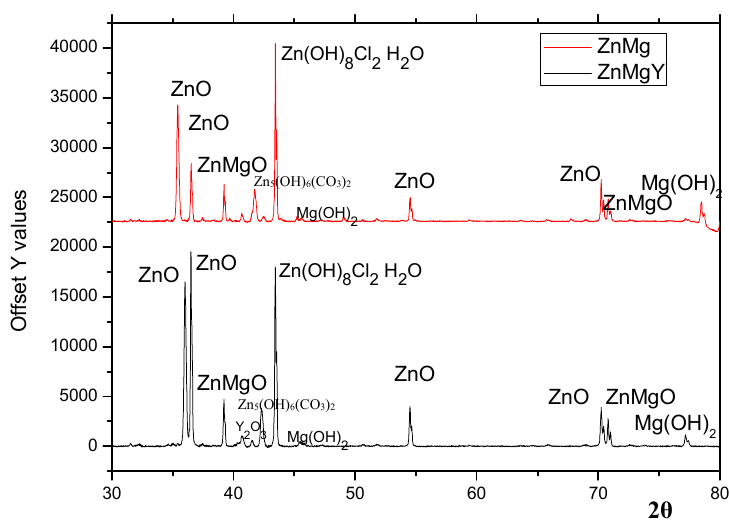
Figure 5. XRD patterns of ZnMg and ZnMgY alloys after 72 h of immersion in SBF. Figure 5. XRD pa tt erns of ZnMg and ZnMgY alloys after 72 h of immersion in SBF. diffractograms [75]. A cluster of peaks attributed to zinc carbonate hydroxide (Zn 5 (CO 3 ) 2 (OH) 6 In addition to ZnO peaks, several brucite (Mg(OH) 2 ) peaks were identi fi ed on both di ff ractograms [75]. A cluster of peaks a tt ributed to zinc carbonate hydroxide (Zn 5 (CO 3 ) 2 (OH) 6 ) was also observed [76]. A small 2 θ peak around 45.5 can be a tt ributed